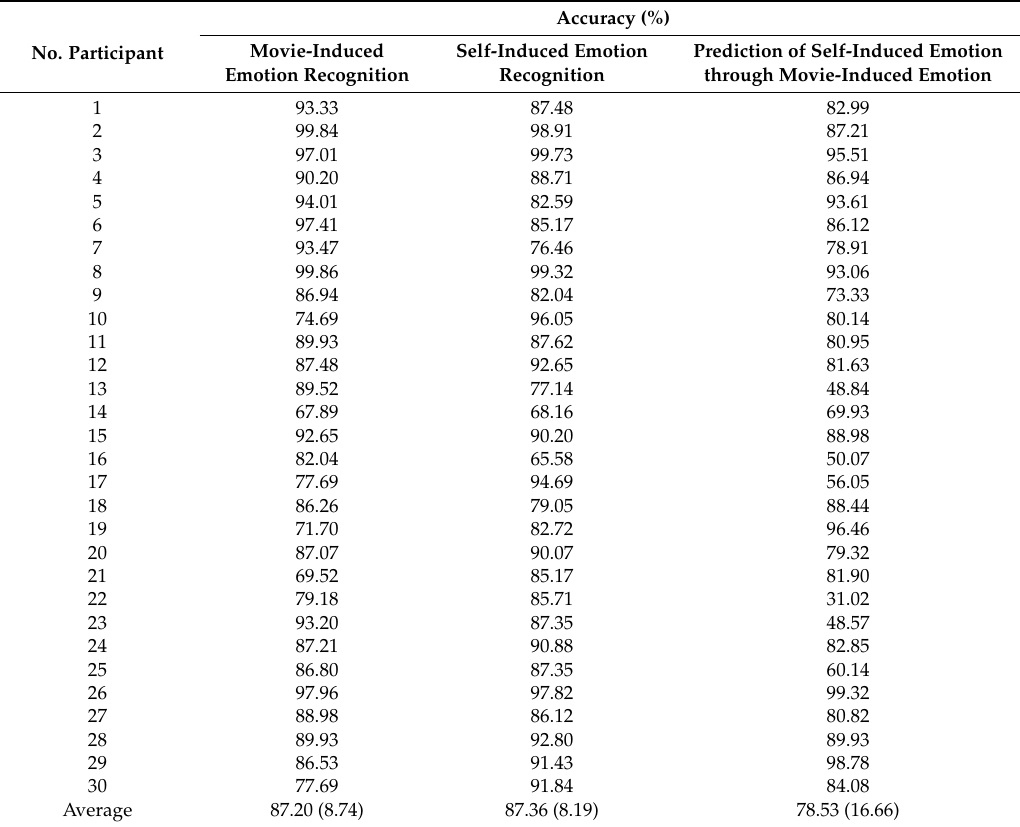
Table 4. Accuracies of binary classification for the discrimination of positive emotions from negative emotions (Standard deviations are shown in